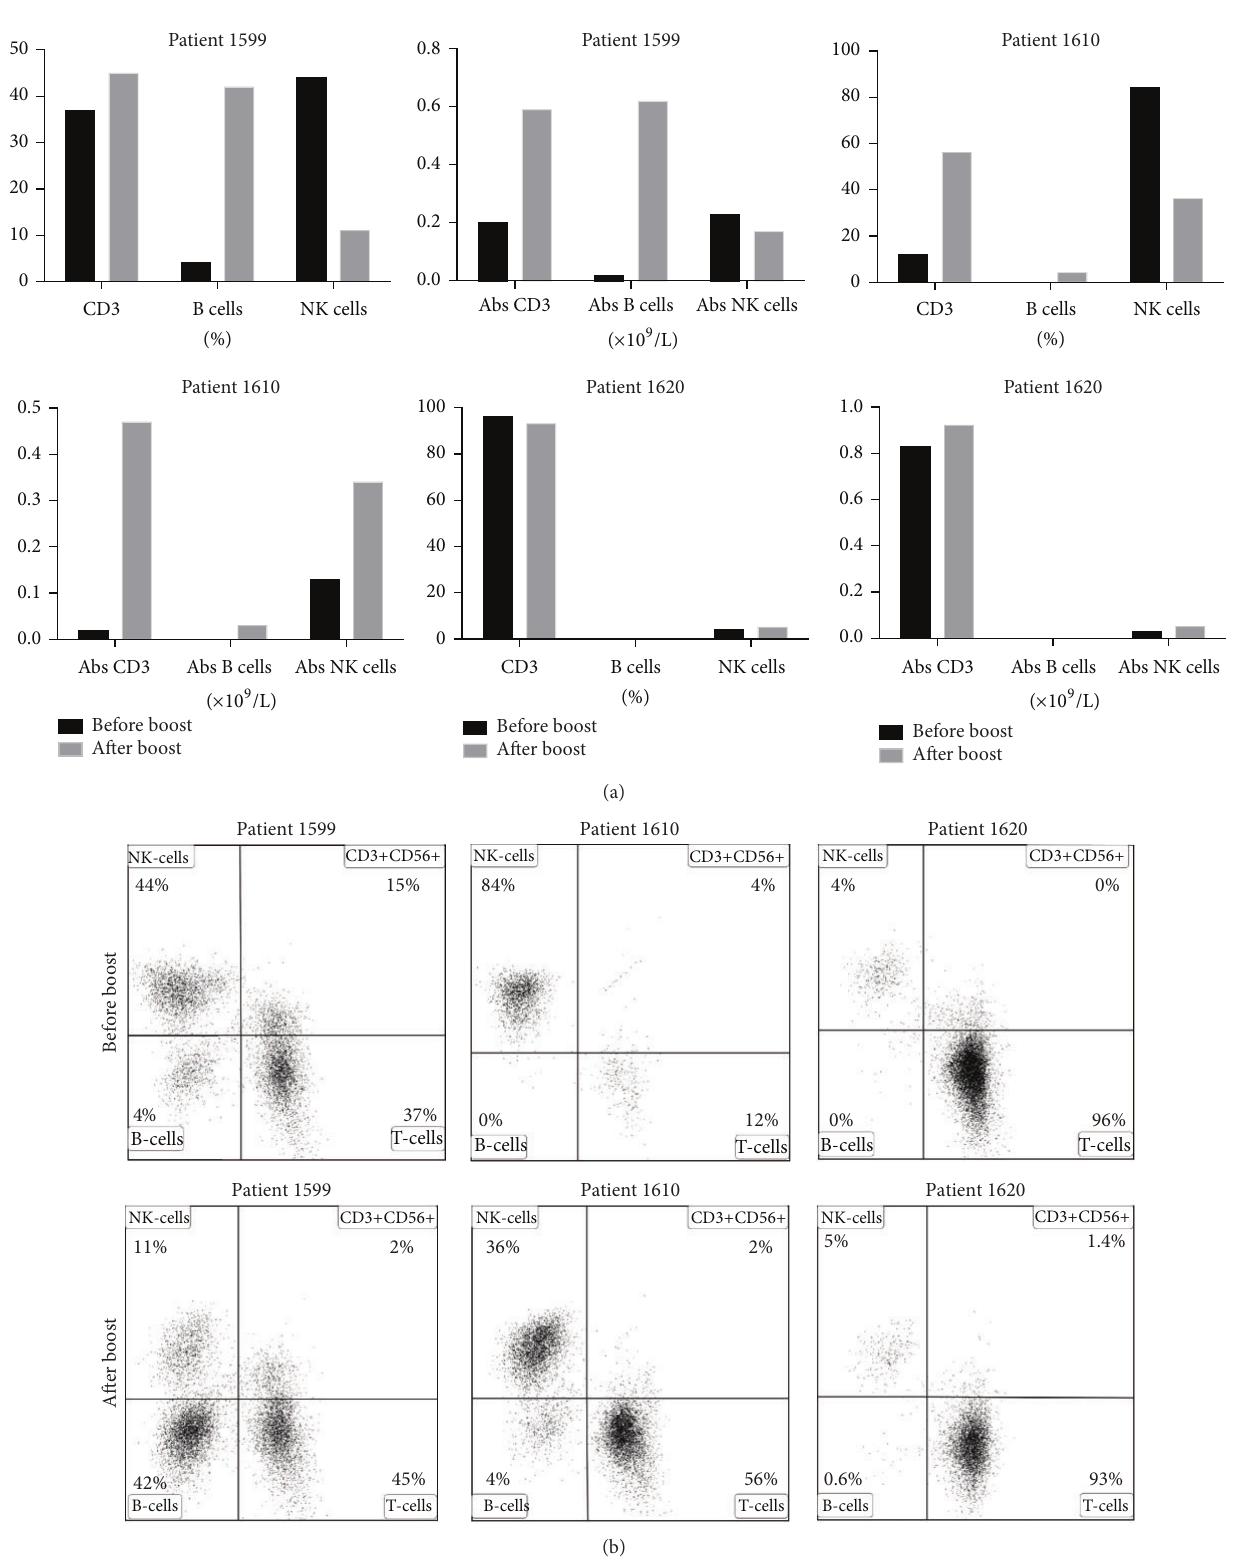
Figure 4: Lymphocyte subpopulations before and after infusion. Blood samples were collected from the patients before and after 𝛼𝛽 -depleted graft infusion and lymphocyte subpopulations were analyzed by flow cytometry. (a) Both percentages and absolute concentrations are plotted. (b) Representative FACS plots of the three patients before and after infusion. The plots are gated from CD45+